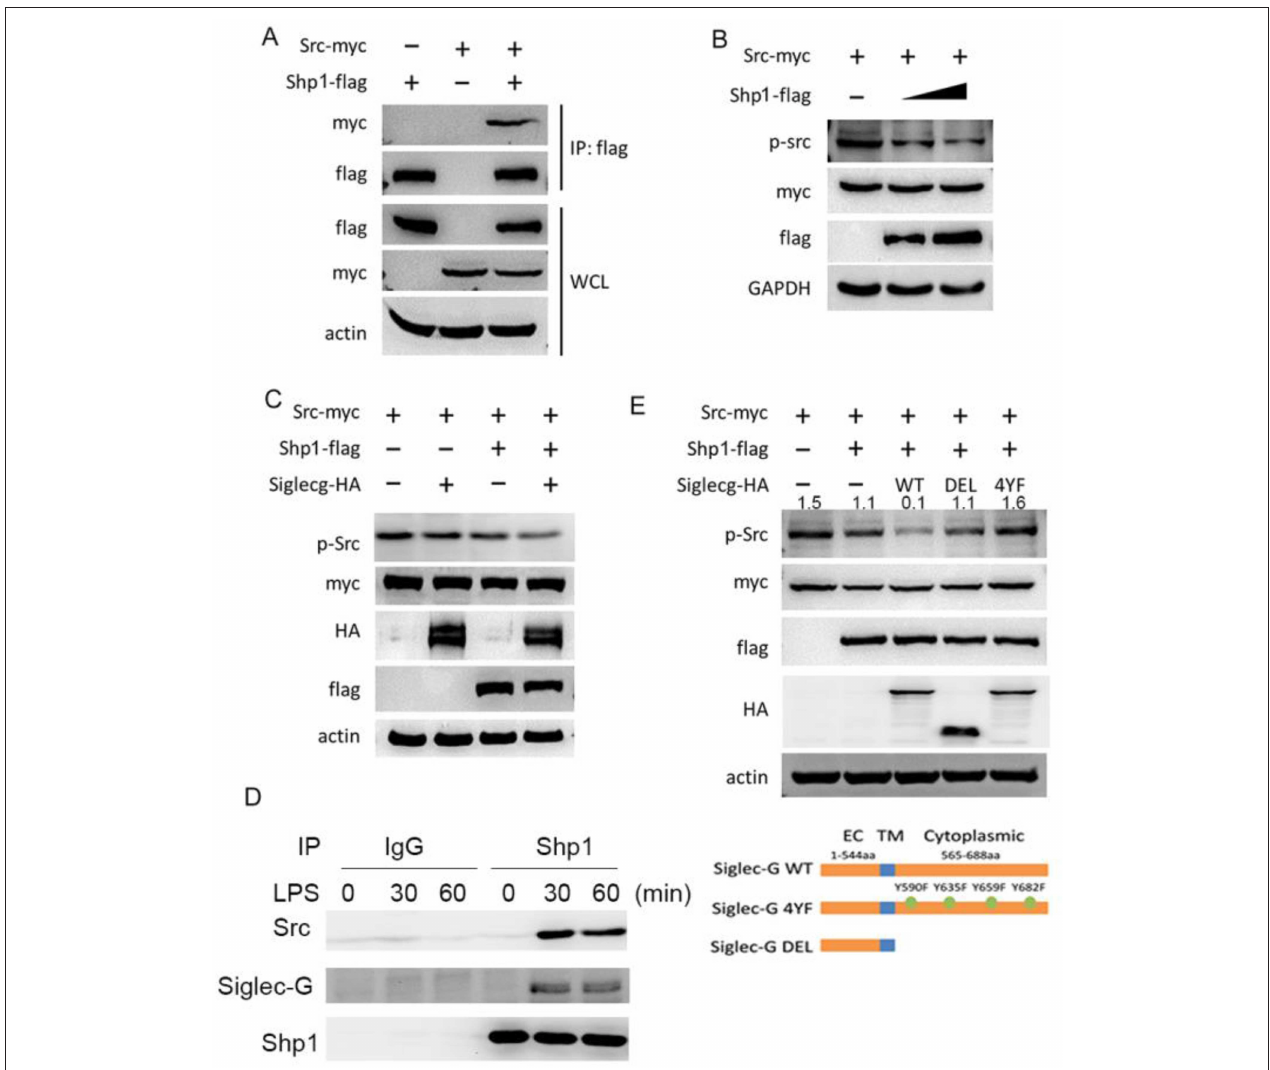
FIGURE 5 | Siglec-G inhibits of Src activation via SHP1. (A) Immunoblotting of immunoprecipitated production or cell lysates from HEK293T cells overexpressing indicated plasmids. (B,C) Immunoblotting of the cell lysates from HEK293T cells overexpressing indicated plasmids. (D) Immunoblotting of immunoprecipitated production from macrophages with indicated antibodies. (E) Immunoblotting of the cell lysates from HEK293T cells overexpressing indicated plasmids. Data are representative of three independent experiments with similar results. SHP1, Src homology region 2 domain-containing